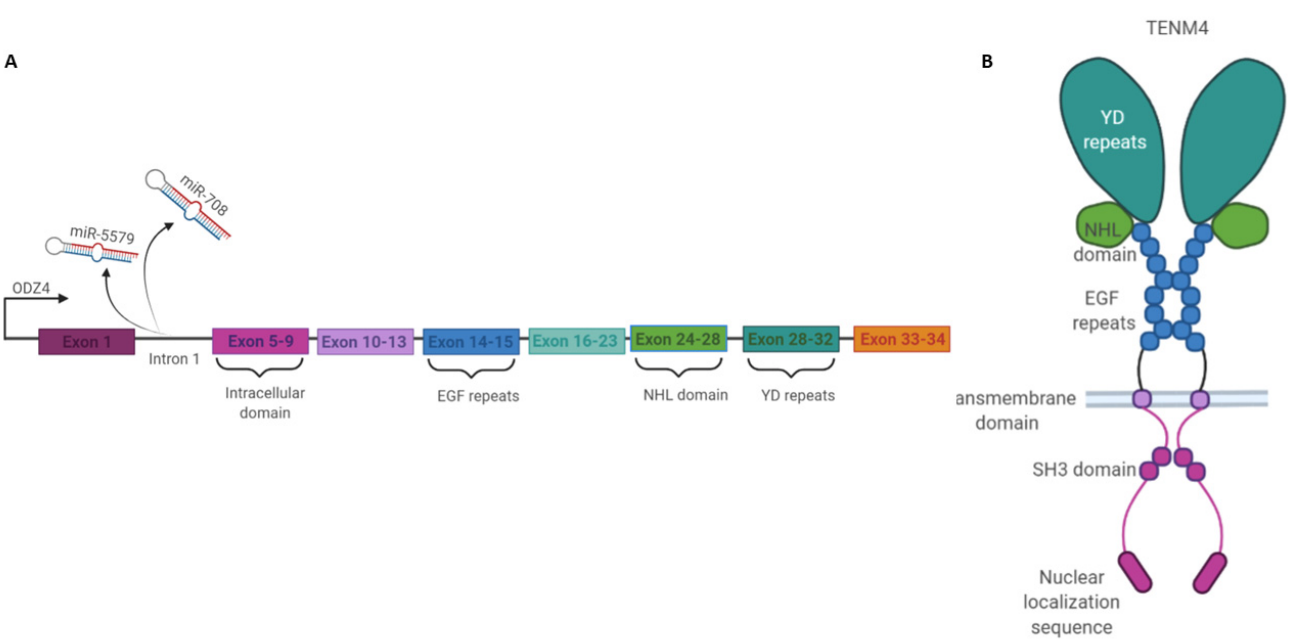
Figure 1. Schematic representation of the ODZ4 gene and of the TENM4 protein structure: ( A ) The ODZ4 gene counts 34 exons (NCBI Gene ID: 26011, updated on 23 November 2021). Two microRNA miR-5579 and miR-708 are situated in the first intron of the ODZ4 gene and spliced out. ( B ) TENM4 protein structure comprehend different domains: an intracellular domain with a nuclear localization sequence and an SH3 binding domain, a transmembrane domain, and an extracellular domain composed by eight EGF repeats, an NHL, and YD domains. “Created with BioRender.com, accessed on 26 November 2021”.